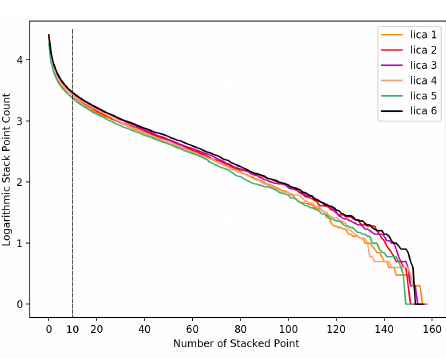
Figure 3. Preprocess of hyperspectral data to generate reflectance image